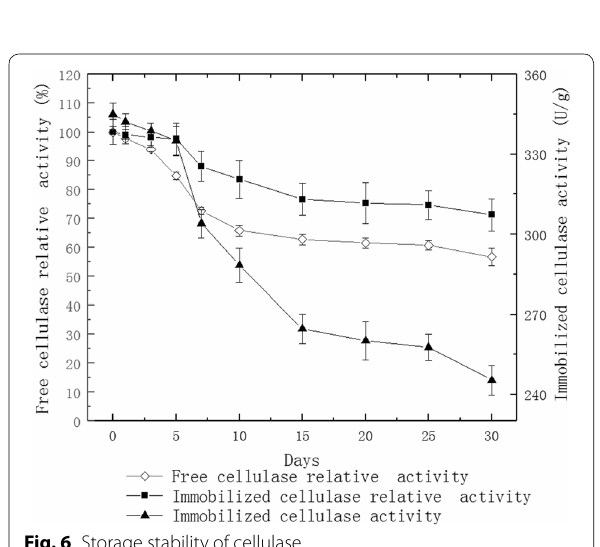
Fig. 5 Cellulase pH stability